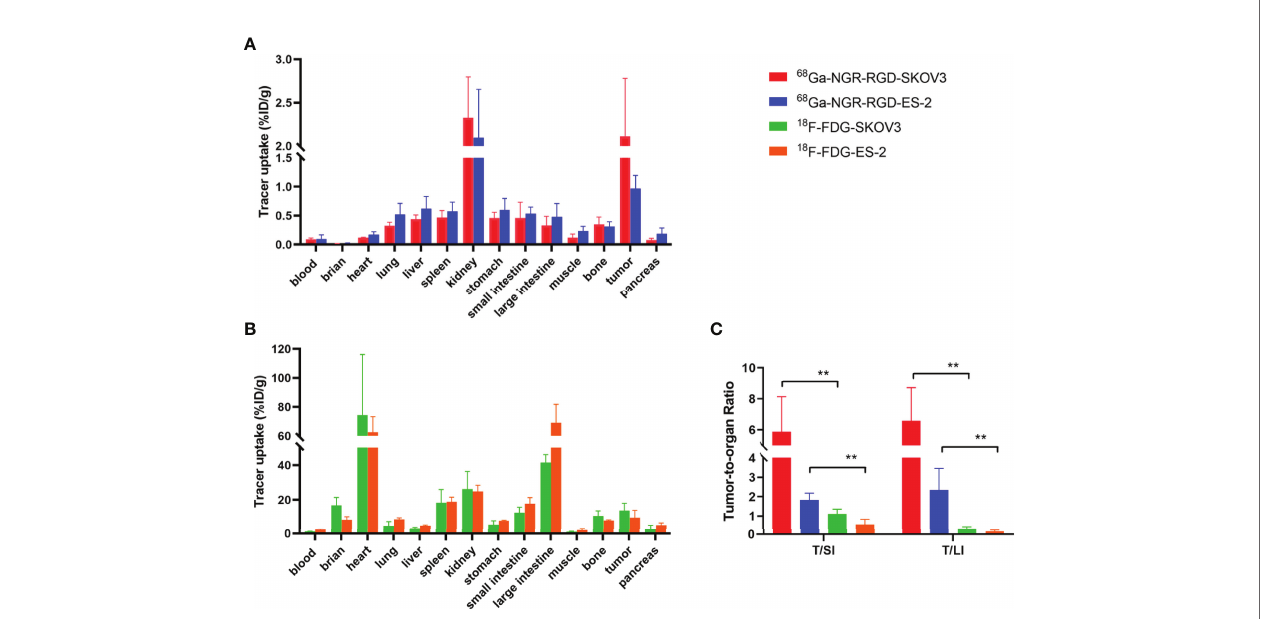
FIGURE 5 | Biodistribution for the validation of PET/CT results. Biodistribution of 68 Ga-NGR-RGD in SKOV3 and ES-2 (A) abdominal metastatic ovarian tumor models and 18 F-FDG in SKOV3 and ES-2 (B) metastatic models at 1 h after tracer injection. (C) Metastatic tumor lesions showed avid 68 Ga-NGR-RGD uptake with a signi fi cantly higher tumor-to-small intestine (T/SI) and tumor-to-large intestine (T/LI) comparing to 18 F-FDG. **p < 0.01. Data are expressed as mean ± SD (n =